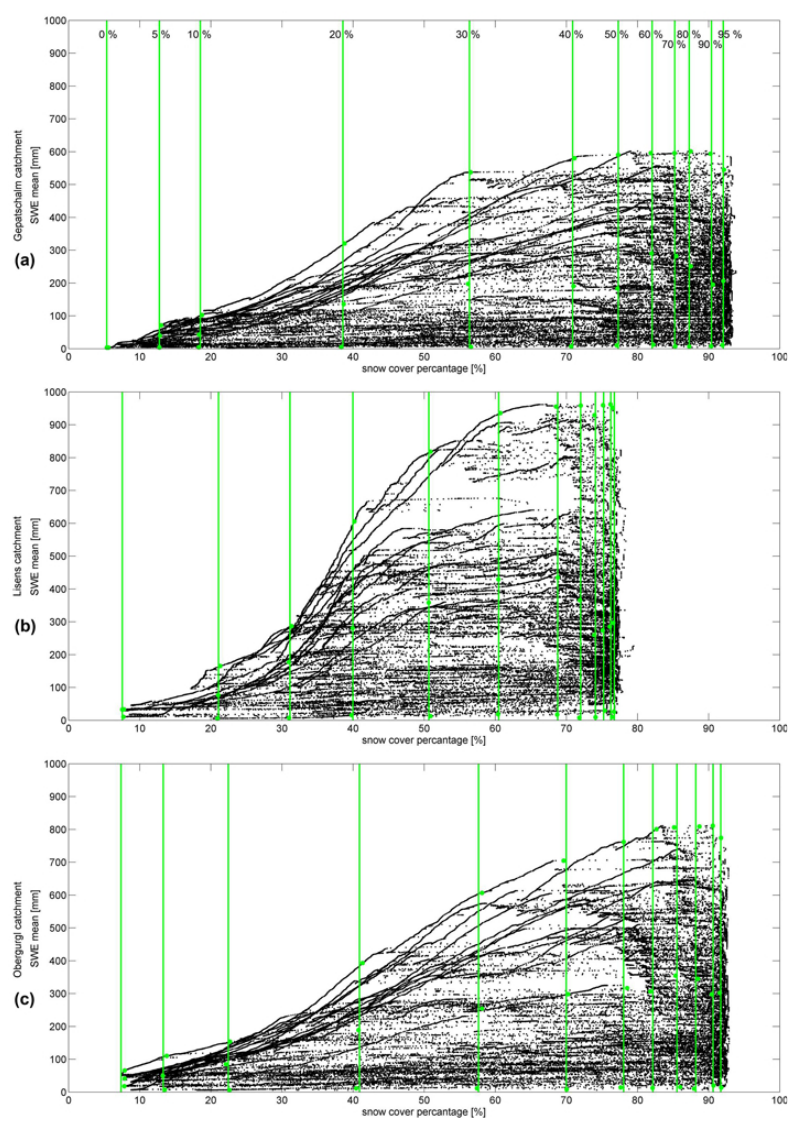
Fig. 4. Plots of simulated mean snow water equivalent [SWE m ; mm] vs. snow coverage [%] in the period of 1995–2009 for catchments (a) Gepatschalm, (b) Lisenerbach and (c) Obergurgl; Vertical green lines: snow cover quantiles (SCQ); Green dots minimum, mean or maximum SWE m